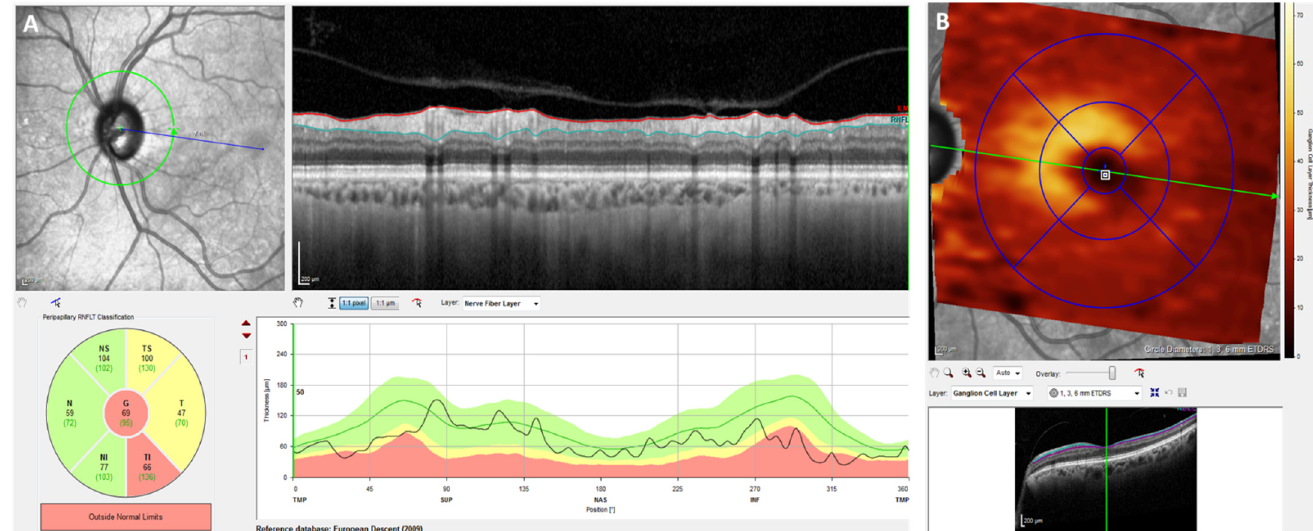
Figure 4. Optic nerve OCT analysis. ( A ): Retinal nerve fiber layer (RNFL) analysis showing optic fiber damage, confirmed on the ( B ) scan image showing particularly an important decrease of the ganglion cell layer (GCL) thickness (yellow part).